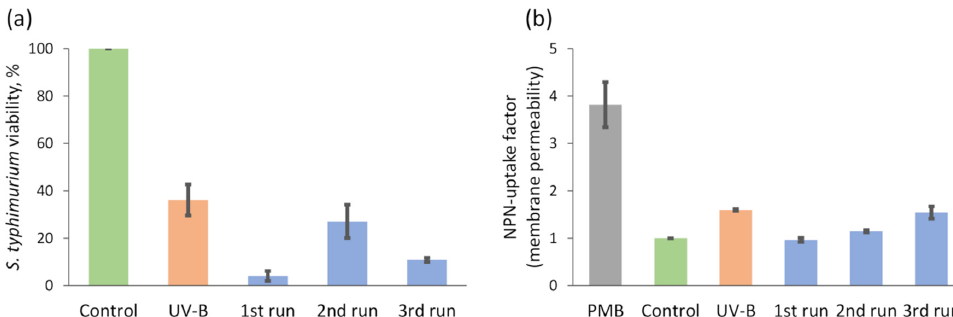
Figure 10. S. typhimurium bacteria photocatalytic inactivation experiments with UV-B light irradiation: ( a ) viability and ( b ) membrane permeability.